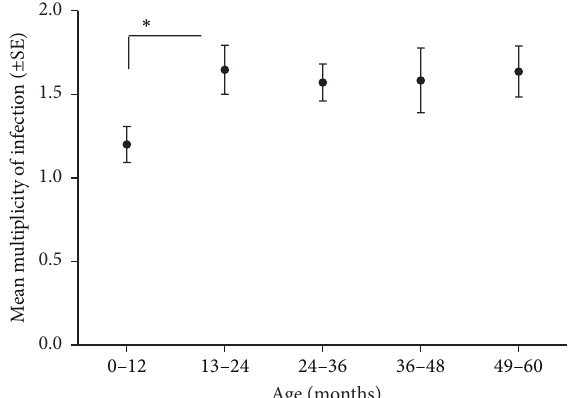
Age Figure 5: Multiplicity of Plasmodium falciparum infections in relation to child age at Kibaha at day 0 ( 𝑁 = 83 , 𝑡 -test, ∗ 𝑝 ≤ 0.02